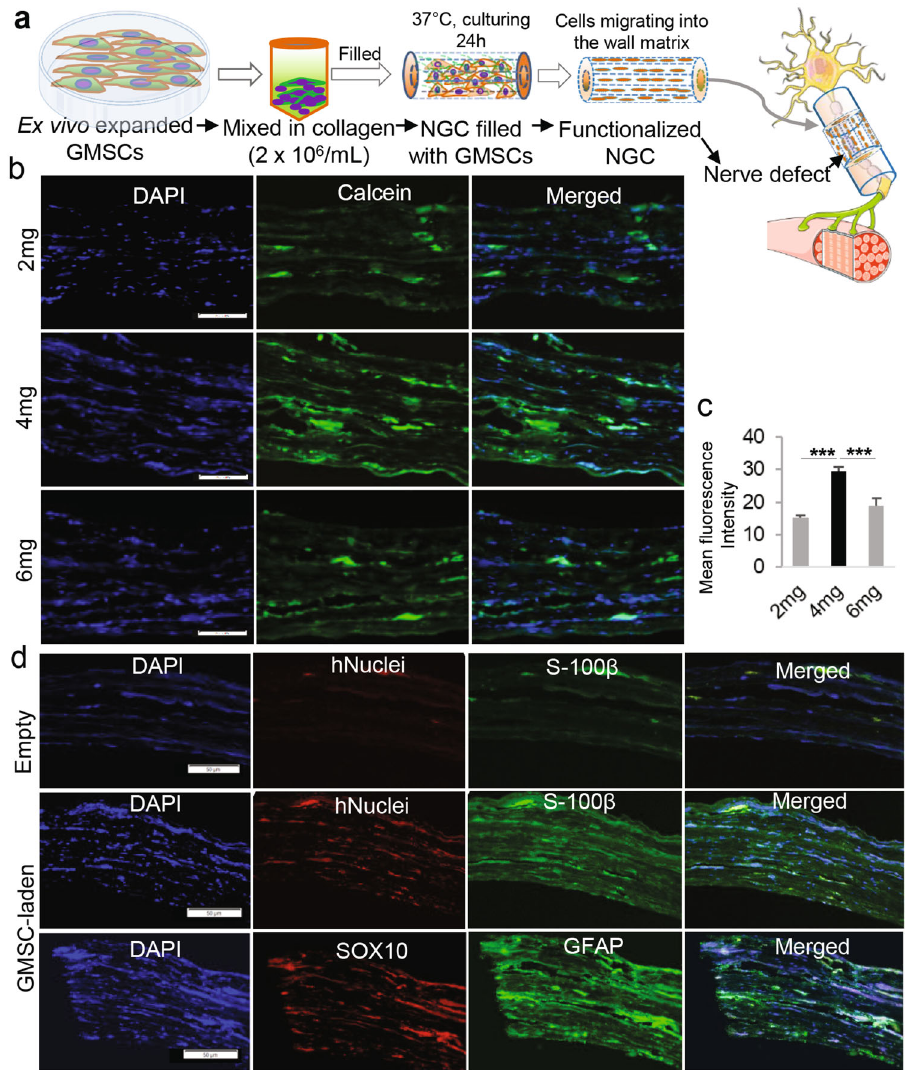
Fig. 7 Generation of functionalized NGCs by harnessing 3D collagen hydrogel-directed conversion of GMSCs into NCSC/SCP-like cells. a GMSCs were encapsulated in 40 µl of 3D-collagen hydrogel at different concentrations (2, 4, 6 mg/mL) and a cell density of 2 × 10 6 /mL and then fi lled into AxoGuard Nerve protector or connector (NGC) (10 mm in length and 2 mm in inner diameter). Then, the constructs (NGC containing 3D collagen hydrogel encapsulated with GMSCs) were cultured for 24 h in complete α -MEM. Portions of this fi gure were made using templates from SMART SERVIER MEDICAL ART (https://smart.servier.com). b Before harvesting, the NGC constructs were labeled with 10 µM calcein-AM at 37 °C for 30 min. Cryosections were cut and the migrated cells labeled with calcein-AM (green color) in the wall matrix were observed under a fl uorescence microscope. Nuclei were counterstained with 4 ′ , 6-diamidino-2-phenylindole (DAPI; blue). c Quanti fi cation of IF intensity of calcein-AM. d Cryosections of NGCs containing cell-free collagen hydrogel (Empty) or GMSC-laden collagen hydrogel at a concentration of 4 mg/mL (Cell-laden) were prepared for dual-color immunostaining for human nuclei (hNuclei; red color), SOX10 (red color), S-100 β (green color) or GFAP (green color). Nuclei were counterstained with 4 ′ , 6-diamidino-2-phenylindole (DAPI; white or blue). Scale bar = 50 µm ( b , d ). *** p < 0.0001. Data represent the mean ± SD, n = 3 biological replicates. One-way ANOVA with the Tukey ’ s post test ( c ). NGC, nerve guidance GMSCs of the NC-origin could be rapidly and consistently converted into NCSC/SCP-like state characterized by increased expression of a panel of NCSC/SCP-related genes and a simultaneous decrease in the expression of MSC-related genes. Our fi ndings have demonstrated a novel approach for the ef fi cient generation of NCSC/SCP-like cells by culturing GMSCs in 3D collagen hydrogel with an optimal stiffness (Figs. 1 and 2). Several master signaling pathways, such as WNT, Sonic Hedge- hog, bone morphogenetic proteins (BMPs), fi broblast growth factor (FGF), transformation growth factor (TGF)- β , and NOTCH signaling, have been identi fi ed as major nodes of the regulatory